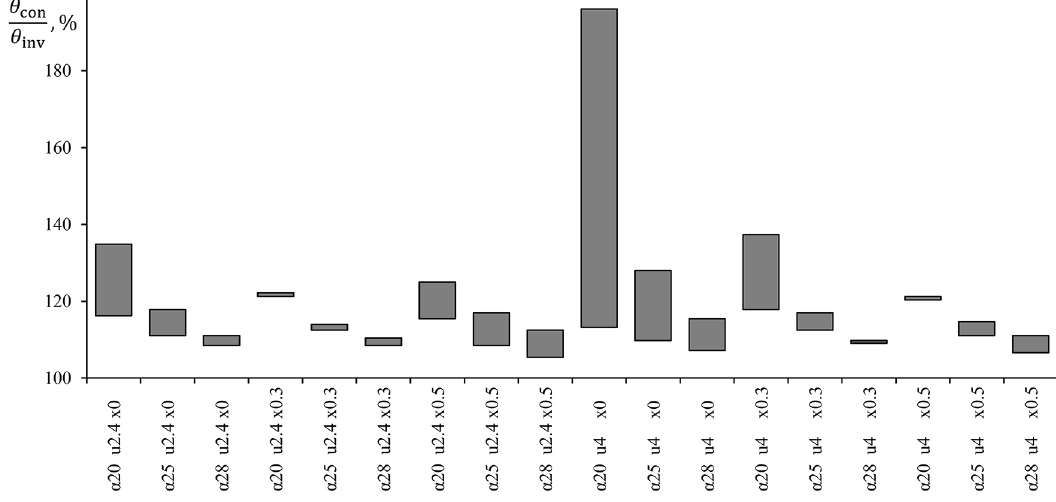
Fig. 3. Ratio between contact strength coef fi cients u con and u inv